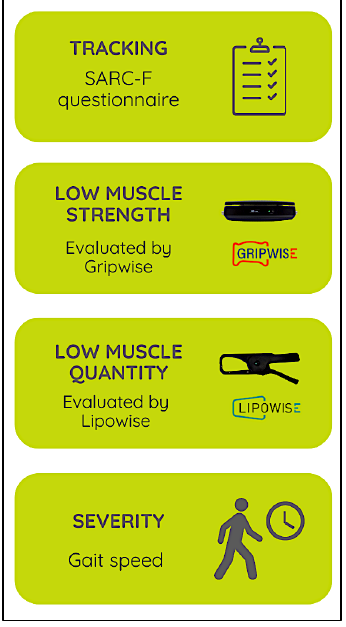
Figure 2. System